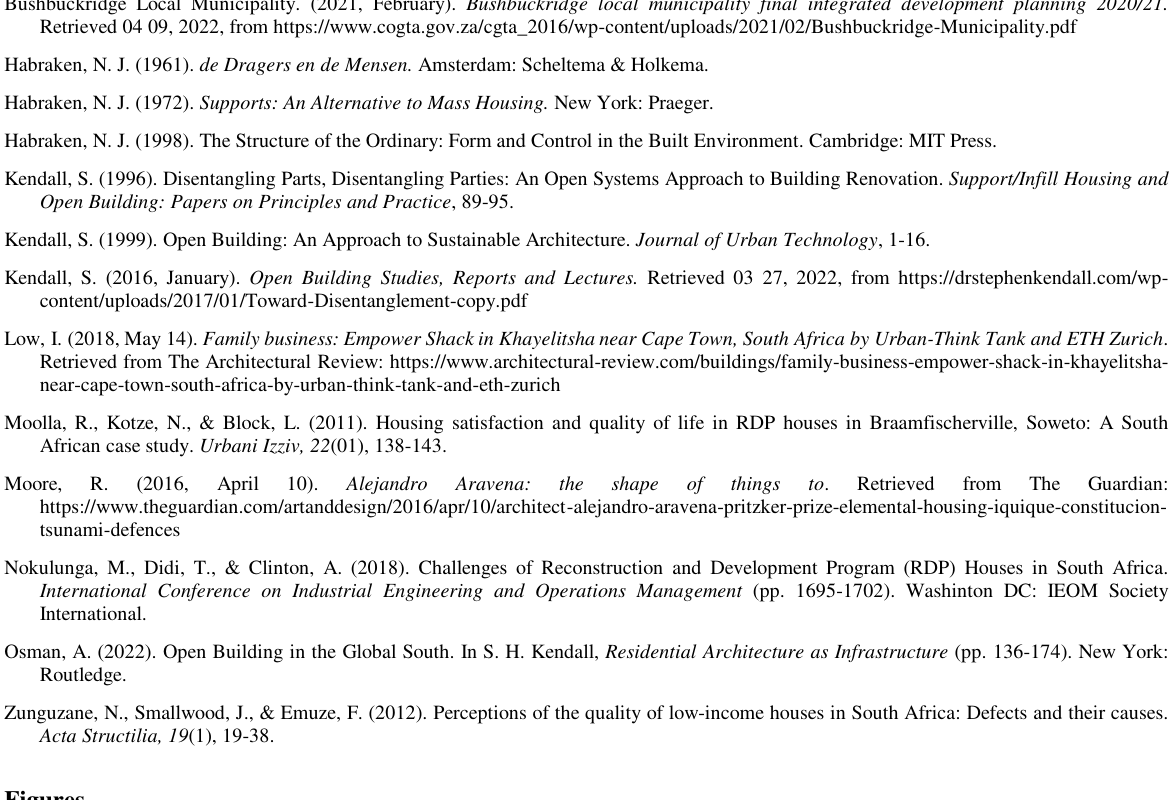
Figure 1: Figure-ground of Braamfischerville illustrating occupant construction. By author, 2022. Figure 2: Elemental ’ s Iquique development, Chile. Archdaily.com, 2016. Available from: https://www.archdaily.com/797779/half-a-house- builds-a-whole-community-elementals-controversial-social-housing/580897bbe58ece3c6600018e-half-a-house-builds-a-whole-community- elementals-controversial-social-housing-image Accessed on: 2022/08/25. Figure 3: Plan and elevation of Half a House illustrating the delivered structure in blue and the intended additions and adaptations in orange. By author, 2022. Figure 4: Occupant infill construction at Iquique . Theguardian.com, 2016. Available from: https://www.theguardian.com/artanddesign/2016/apr/10/architect-alejandro-aravena-pritzker-prize-elemental-housing-iquique-constitucion- tsunami-defences Accessed on: 2022/08/25. Figure 5 : Elemental's Villa Verde project, Chile, with additional infrastructure over the incomplete half of the house. Archdaily, 2016. Available from: https://www.archdaily.com/797779/half-a-house-builds-a-whole-community-elementals-controversial-social- housing/580897e4e58ece68aa0002dd-half-a-house-builds-a-whole-community-elementals-controversial-social-housing-image Accessed on: